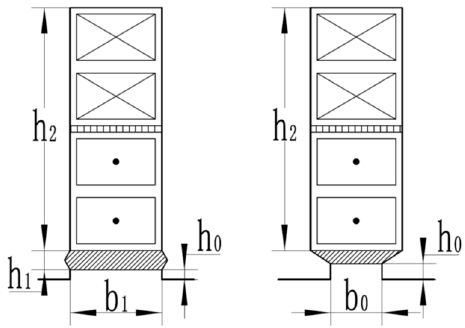
Figure 9. Dimensions of constructed stator slot.